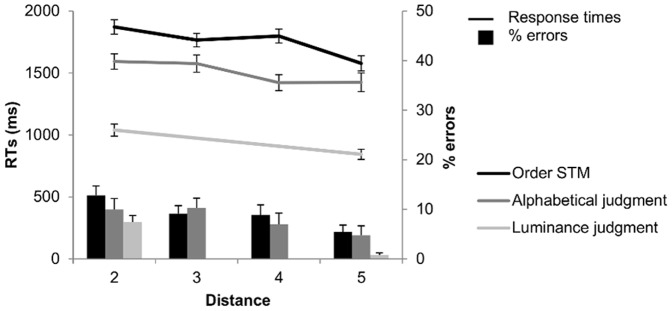
Response times and errors percentage for the order judgment tasks.Behavioral performances in order STM, alphabetical judgment, and luminance judgment tasks, as a function of positional, alphabetical and luminance distance, respectively.